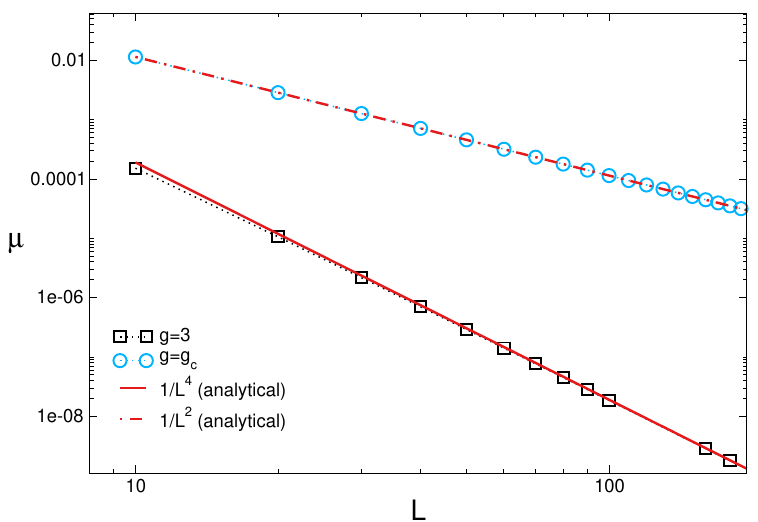
(cid:39) 9.67 and in the ordered c